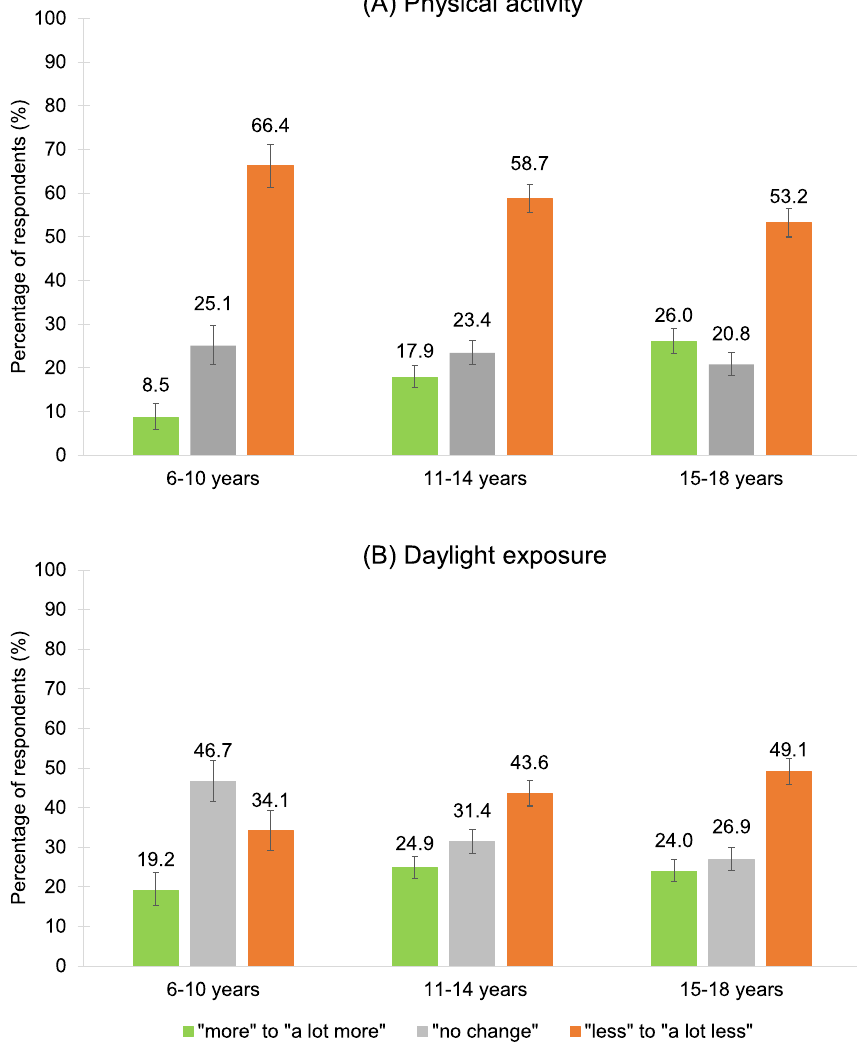
Figure 7. Changes in ( A ) physical activity and ( B ) daylight exposure. ( A ) More than half of the participants were “less” or “a lot less” active during COVID-19 compared to before. With almost 70%, the youngest age group (6–10 years) showed the highest reduction of activity levels. ( B ) An average of 42% experienced “less” or “a lot less” daylight exposure during